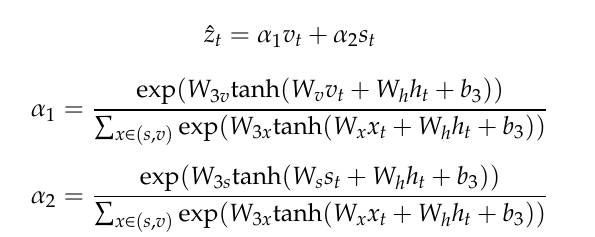
v and s are obtained by attention1 and t t